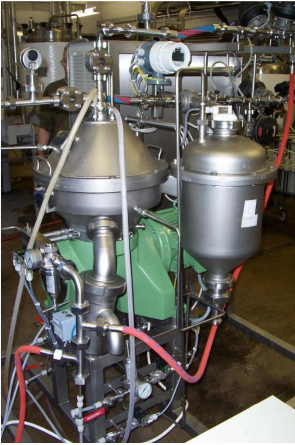
Figure 2. A disc stack centrifuge (5 hL per hour)